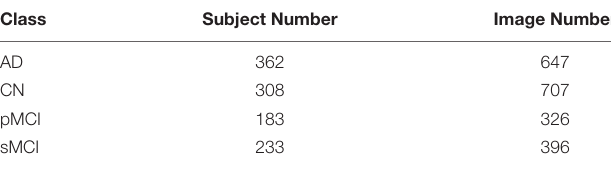
TABLE 1 | Summary of the studied subjects and images from the